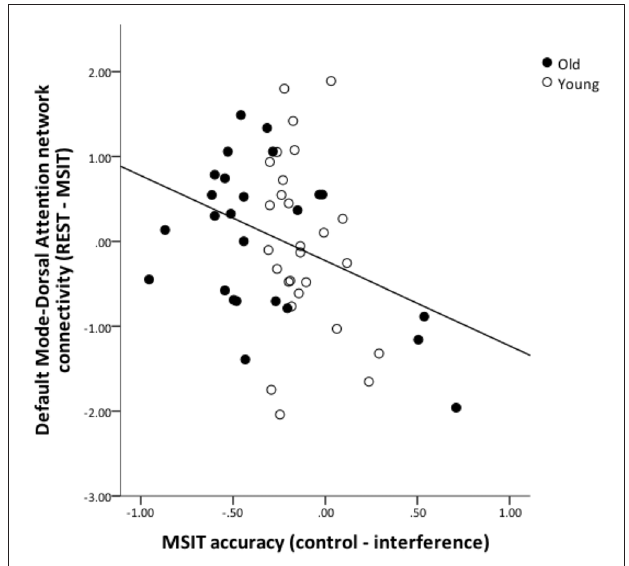
FIGURE 6 | The relation between DMN and DAN coupling and MSIT accuracy. The graph shows the residuals of the change-change age-partialed correlation between DMN-DAN connectivity (rest—task) and accuracy during the MSIT (correct responses for control items—correct responses for interference